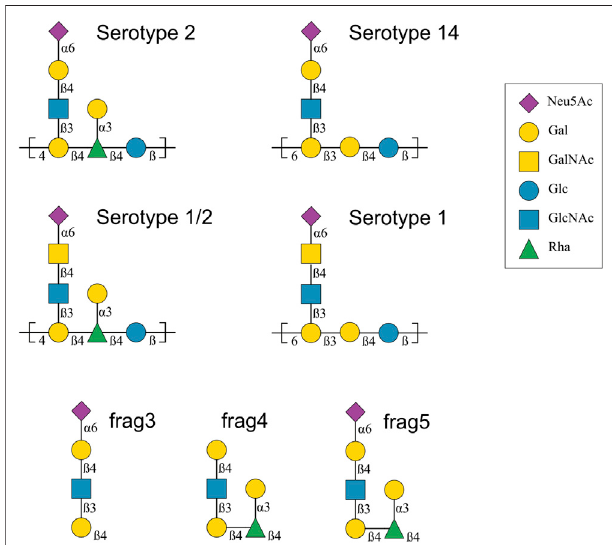
FIGURE 1 | Capsular polysaccharide repeating unit structures for Streptococcus suis serotypes 2, 14, 1/2 and 1 and 14 (Van Calsteren et al., 2010; Van Calsteren et al., 2013; Van Calsteren et al., 2016), as well as the structure of three Ss2 oligosaccharide vaccine candidates, labelled frag3, frag4 and frag5 (Zhang et al., 2021). The graphical representations use the Symbol Nomenclature for Glycans (SNFG) (Varki et al., 2015). Abbreviations: D -glucose (Glc), D -galactose (Gal), N-acetyl- D -glucosamine (GlcNAc), N-acetyl- D -galactosamine (GalNAc), L -rhamnose (Rha), N-acetyl- D - neuraminic acid